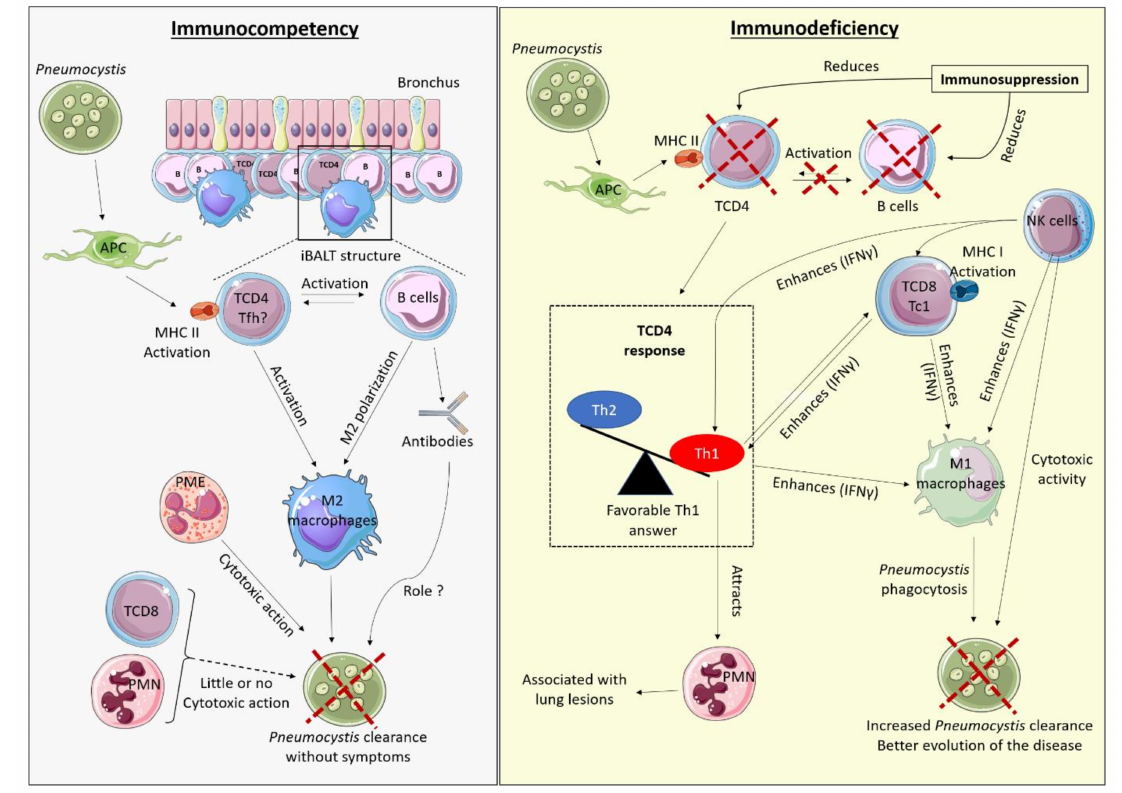
Figure 1. Hypothetical model of the host immune responses during Pneumocystis infection in the immunocompetent and immunosuppressed host. APC: Antigen Presenting Cells, iBALT: induced-Bronchus Associated Lymphoid Tissue, Tfh: T follicular helper, PMN: Polymorphonuclear neutrophils, PME: Polymorphonuclear eosinophils, MHC: